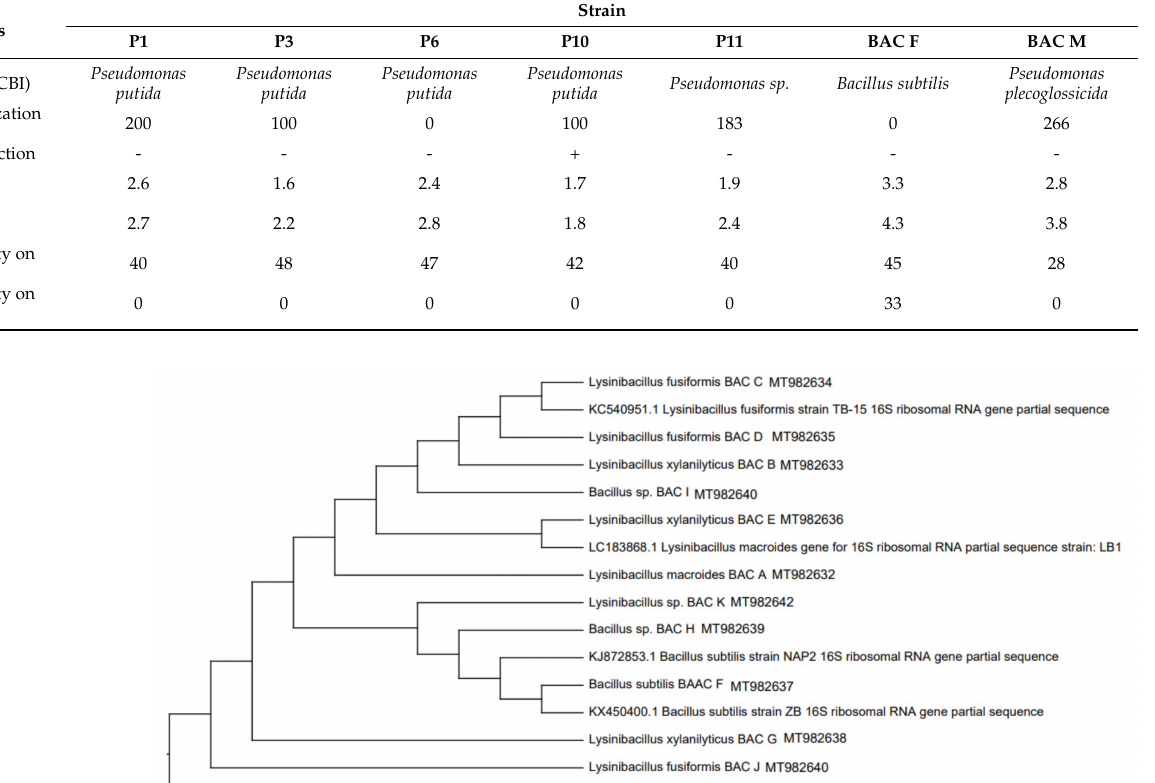
Table 1. PGPR activity of selected Bacillus and Pseudomonas strains.